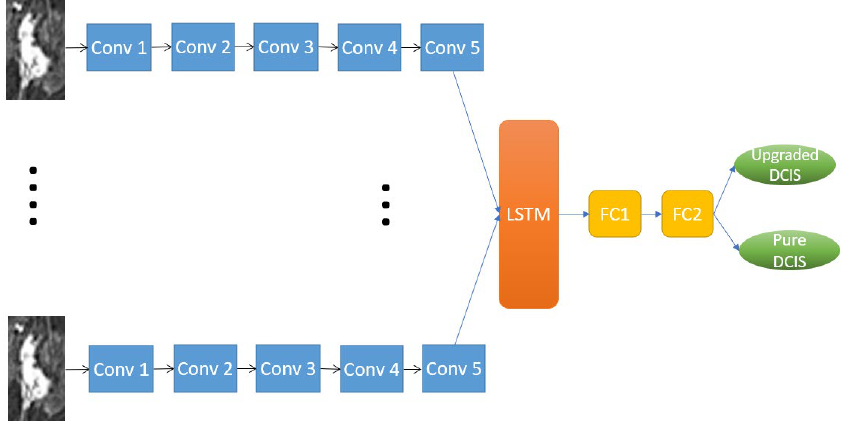
Figure 4. The diagram of the Recurrent Residual Convolutional Neural Network (RRCNN) with ROIs model. Please refer to Figure 5 for the architecture of the convolution blocks. Conv, convolution block; LSTM, long short-term memory; FC, fully connected